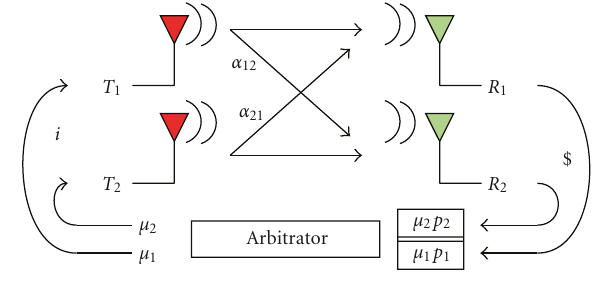
Figure 1: System